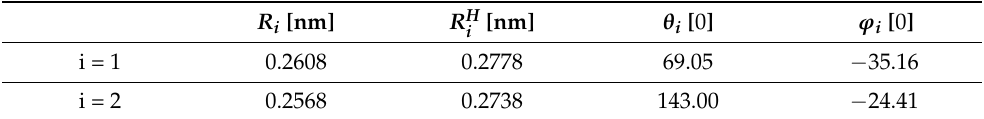
Table 1. The structural data for Ce 3+ ion in the barium site Ba 2+ in the barium tungstate (BaWO 4 ) [44]. R i [nm] R H [nm] θ i [ 0 ] ϕ i [ 0 ] i i = 1 0.2608 0.2778 0.2568 143.00 − 24.41